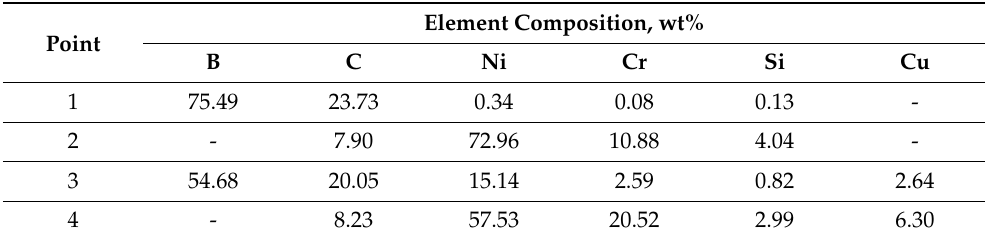
Figure 3. SEM EDX element distribution map of the cross-section of NiCr-70B 4 C coating on the target surface. Table 3. Chemical composition of the cross-section of NiCr-70B 4 C coating on the target surface (Figure 3).